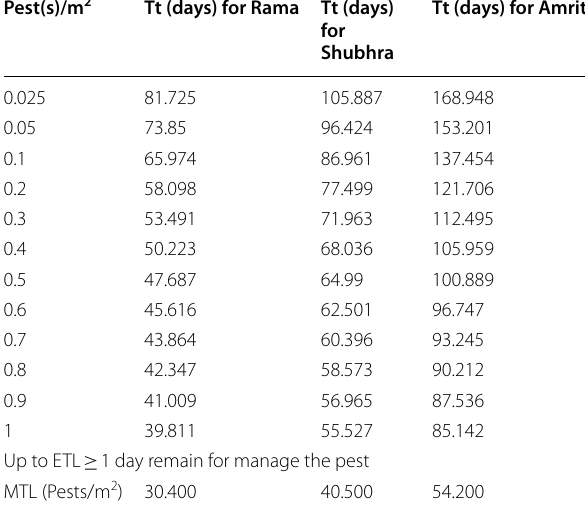
Table 8 Time Series for find the specific time (Tt days) to reach ETL (Mean SE of 3 observations/crop) for any number of pest(S) ± [ S. obliqua Walkar] on the selected sesame ( S. indicum ) cultivars (Rama, Shubhra and Amrit) observed over a traditional synthetic pesticide (Triazophos 40 EC) along with control (without pesticide) side by side having plant density of 30 2 plants/m 2 ± during summer season in